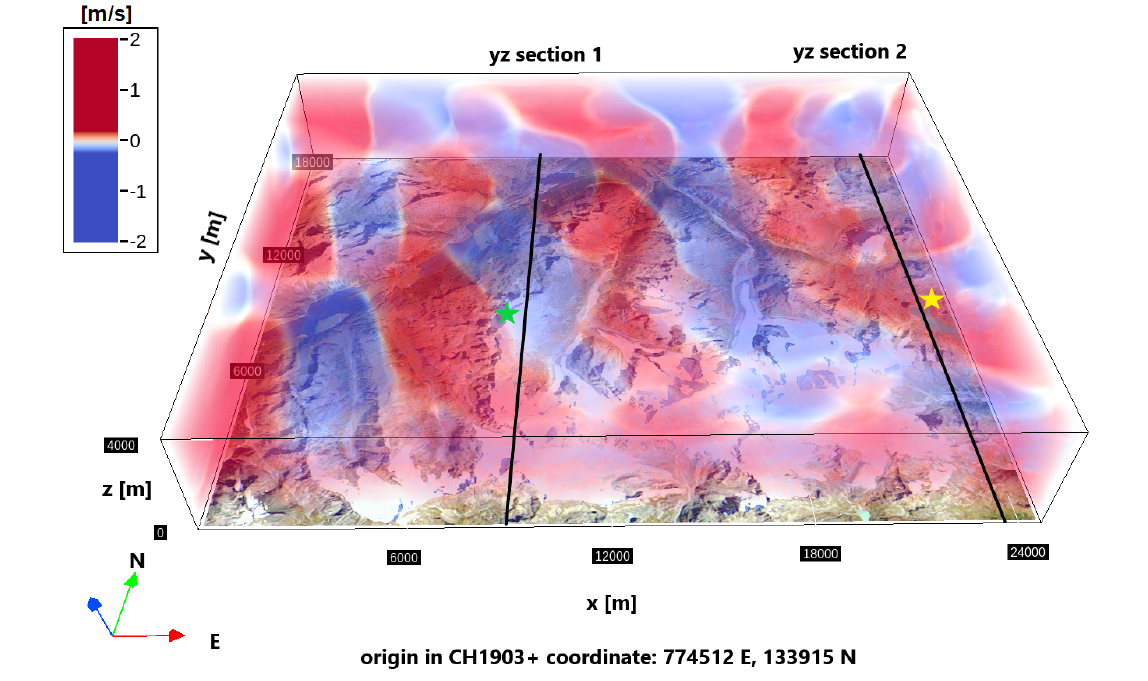
Figure 13. Instantaneous vertical wind speed over the whole 3D domain with the original located at 10,800 s after start of the simulation at 06:00 UTC. The 3D volume rendering is displayed over the landsat satellite image of the computation domain (source of the original images: the Federal Office of Topography in Switzerland). The solid black lines denote the locations the y-z cross-section plots shown in Figure 14, at x = 8704 m (position 1) and x = 23,840 m (position 2) in the local simulation